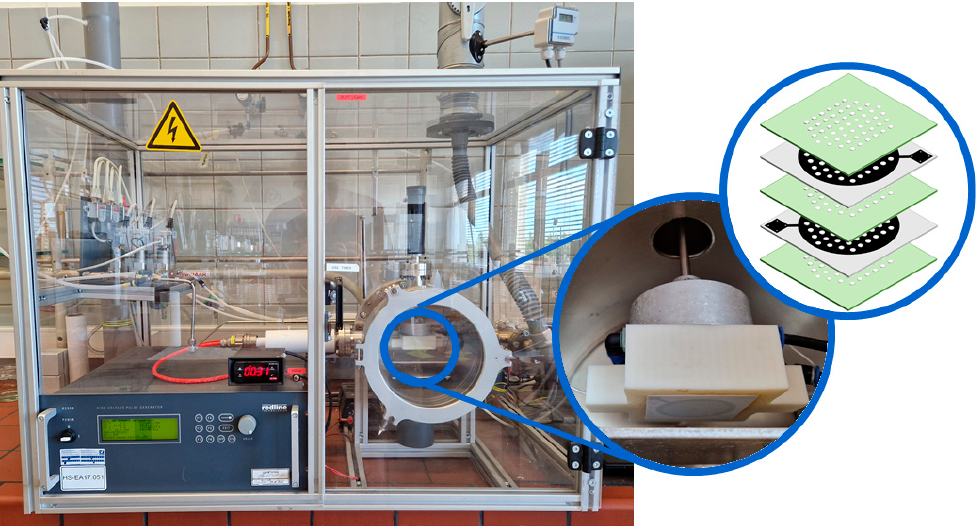
Figure 1. Multi-hollow surface dielectric barrier discharge setup used in the current study. On the right, a detailed image and schematic overview of the electrode system are presented (green = dielectric; black = electrode).